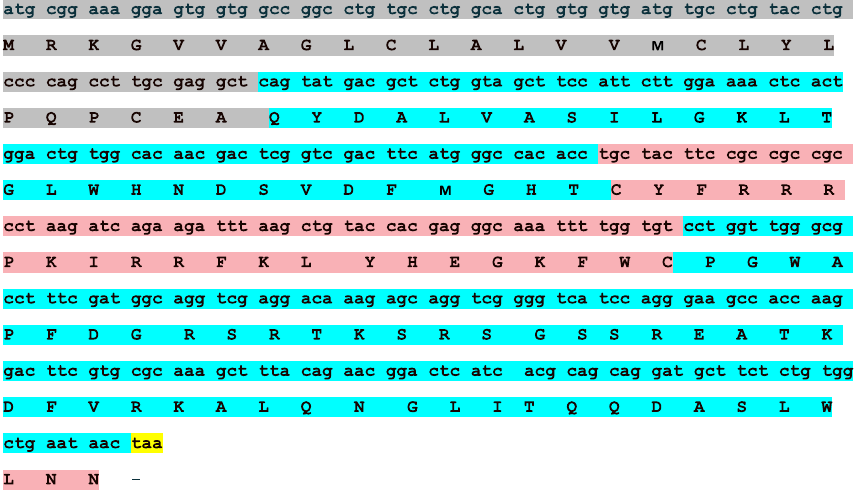
Fig. 1 Nucleotide and deduced amino acid sequences of P. pelagicus ALF, Pp -ALF (OP009359). The single-letter amino acid code is show below the corresponding nucleotide sequence. The gray highlighted region represents the signal peptide, blue represents the mature region, and red indicates the LPS